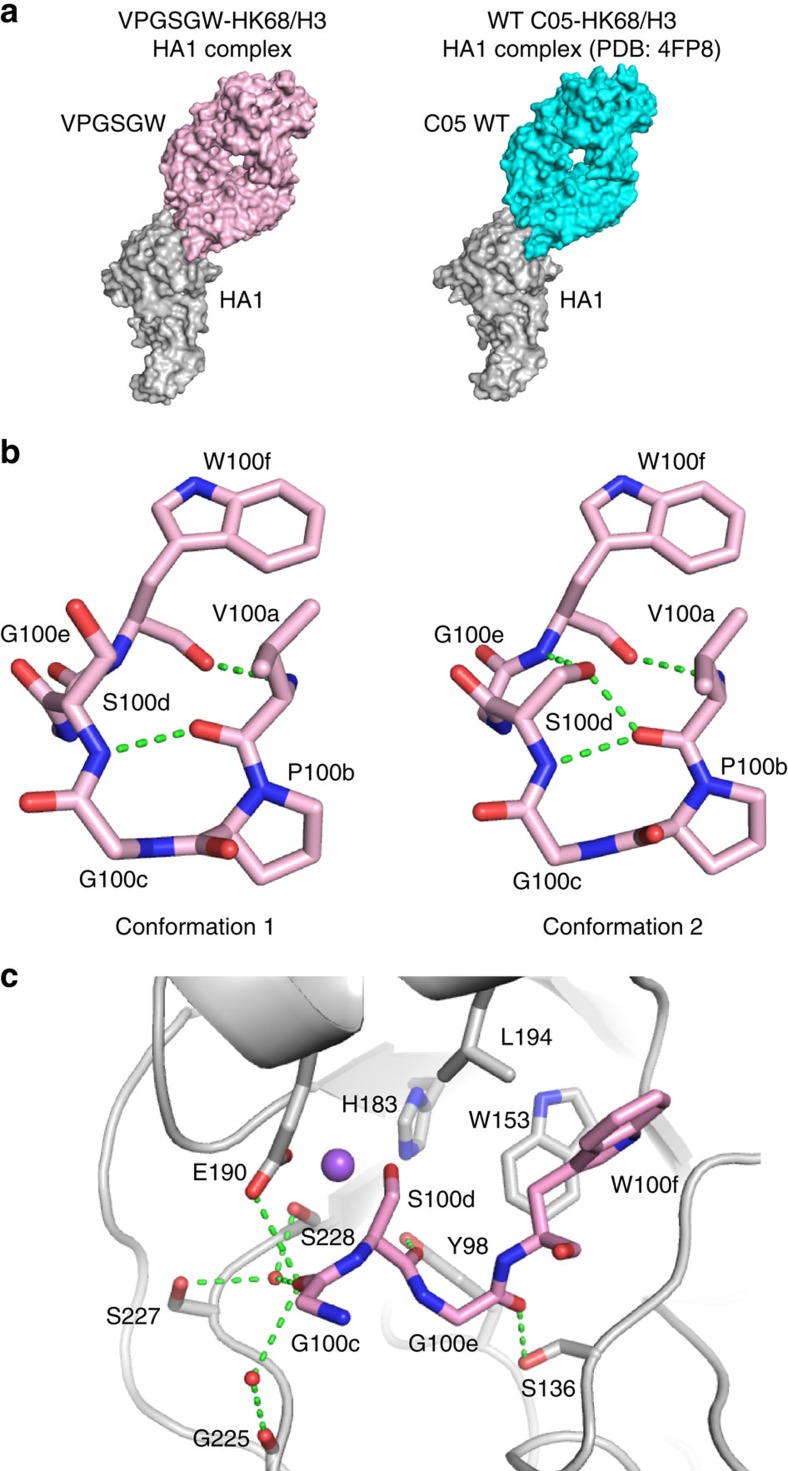
Interaction between VPGSGW and HK68/H3 HA1.(a) The crystal structure of VPGSGW in complex with HA1 exhibits a similar conformation to that of C05 WT in complex with HA1 (PDB: 4FP8)21. (b) There are two VPGSGW-HA1 complexes in the asymmetric unit of the crystal structure. The orientations of the serine at 100d differ between those two complexes. Intramolecular hydrogen bonds are shown for the two different conformations of CDR H3 of VPGSGW. (c) Interaction of the HA RBS (grey) with CDR H3 (pink) is shown. Hydrogen bonds are represented by green dashed lines. Water molecules are represented by red spheres. A putative sodium ion is represented by the purple sphere. For clarity, only G100c, S100d, G100e, and W100f on the CDR H3 of VPGSGW are displayed.